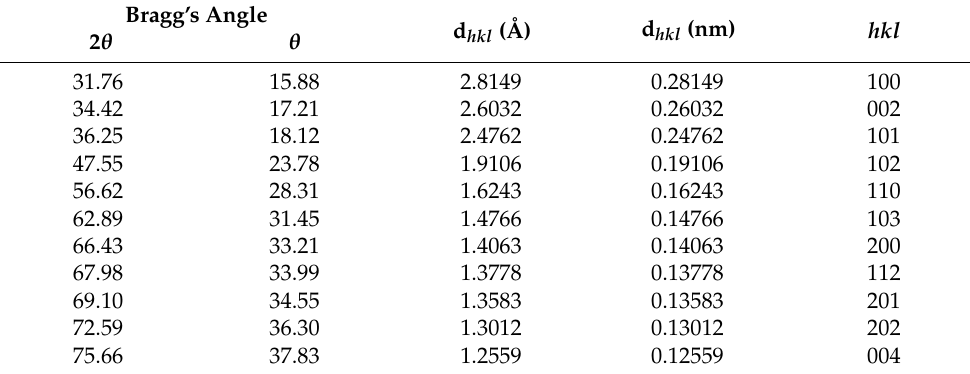
Table 3. d-spacing calculations for ZnChlor powder.